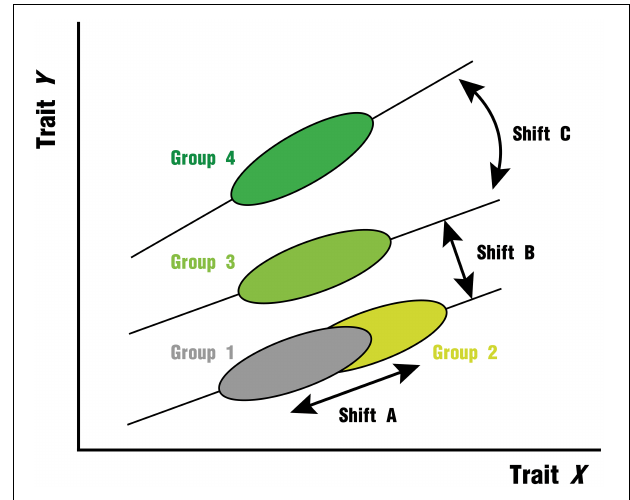
FIGURE 1 | Hypotheses for shifts in leaf trait relationships based on allometric relationships (Adapted from Wright et al., 2001). (1) Shift A indicates that the trait pairs of the two groups are on a common axis without heterogeneity in slope or intercept; (2) Shift B indicates that the slope of the trait relationship is similar between the two groups, but the difference in intercept is significant; (3) Shift C indicates that the slope of the trait relationship between the two groups is heterogeneous. Modulated by climatic resources (e.g., precipitation, temperature), shifts B and C are both possible. Furthermore, we cannot exclude the influence of biogeographic differences inherent in the region (e.g., species composition, evolutionary history) may have an